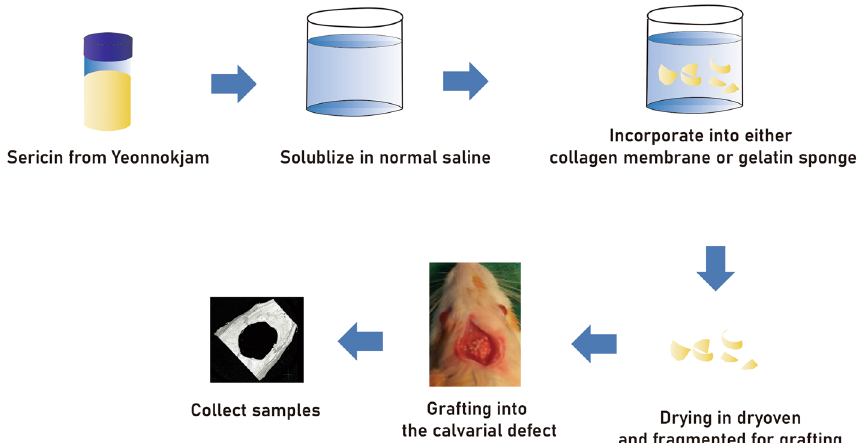
Fig. 1 Schematic drawings of experimental